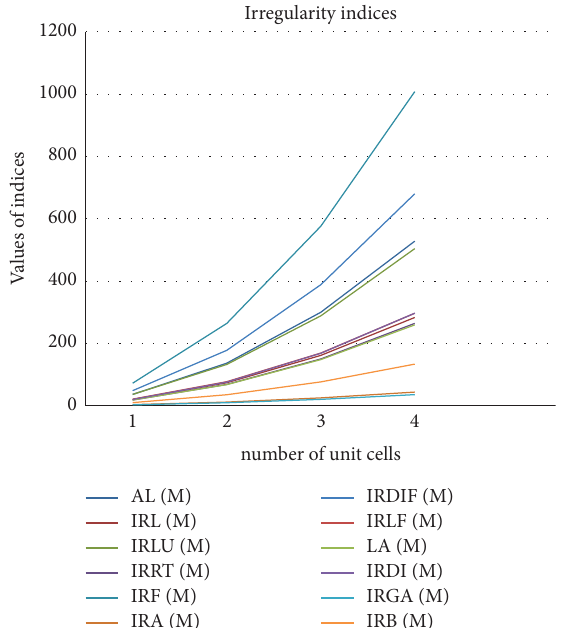
Figure 3: Comparison of irregular topological indices of 2D structure of supramolecular sheet of fuchsine acid C H N HCl [ a,b ] 20 19 3